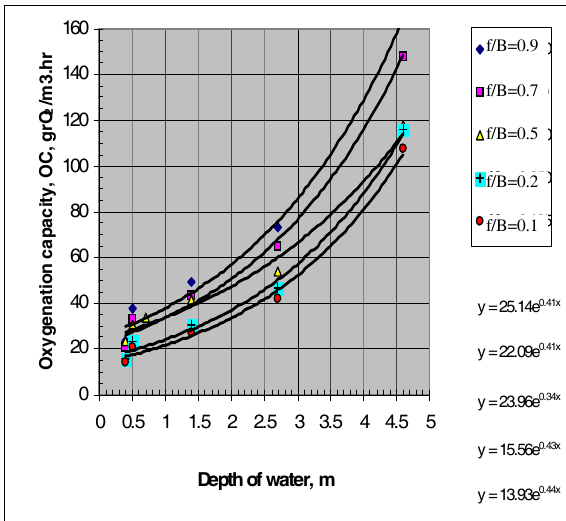
Figure 5: Effect of depth of water on the oxygen transfer capacity (OC) of the system air at constant air flow rate.